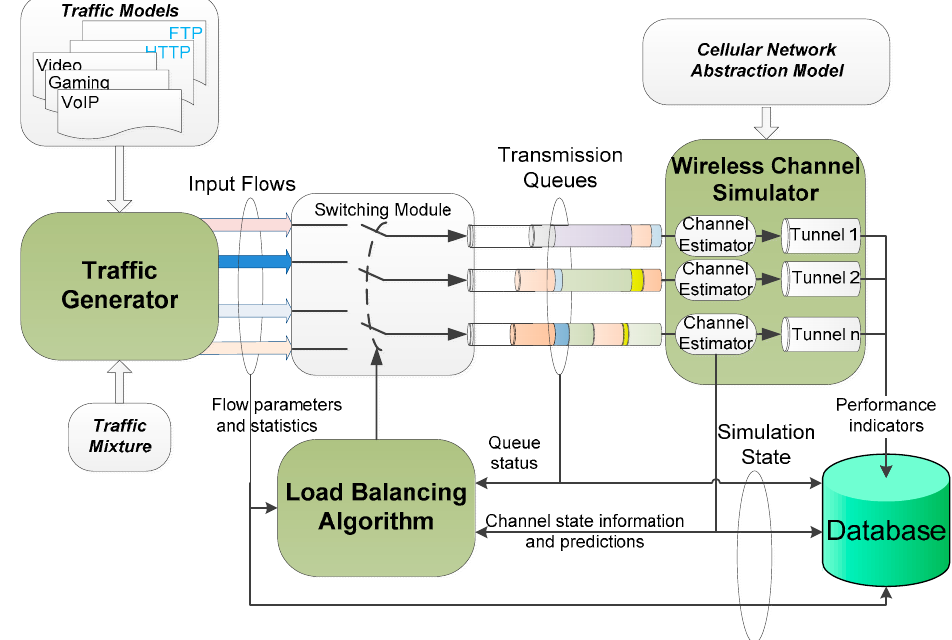
Figure 6. The block diagram of the simulation platform used for the evaluation of the LB algo- rithms.